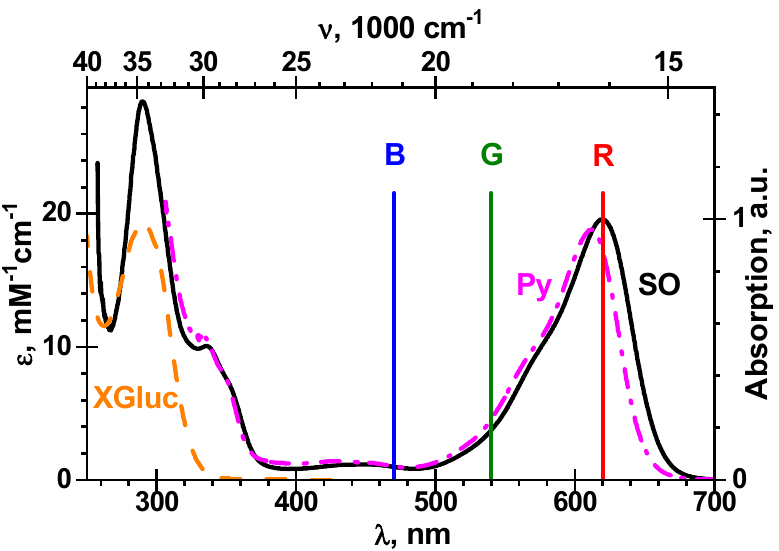
Figure 5. Absorption spectra of chromogenic substrate S , X-Gluc (X-Gluc, dash, orange; for chemical structure, see Figure 1, in PBS, extinction coefficient ( ε ) of indigo in dimethyl sulfoxide (DMSO) (SO, solid, black) and pyridine (Py, dash dot, magenta) at 25 °C. The maxima of indigo in DMSO are located as ε max = 19,600 and 28,500 M − 1 cm − 1 at 619.6 and 289.0 nm, respectively, while the maximum of indigo in pyridine is found as ε max = 18,800 M − 1 cm − 1 at 611.7 nm. The centers of red-green-blue ( RGB ) bands [35] are indicated with the vertical lines.